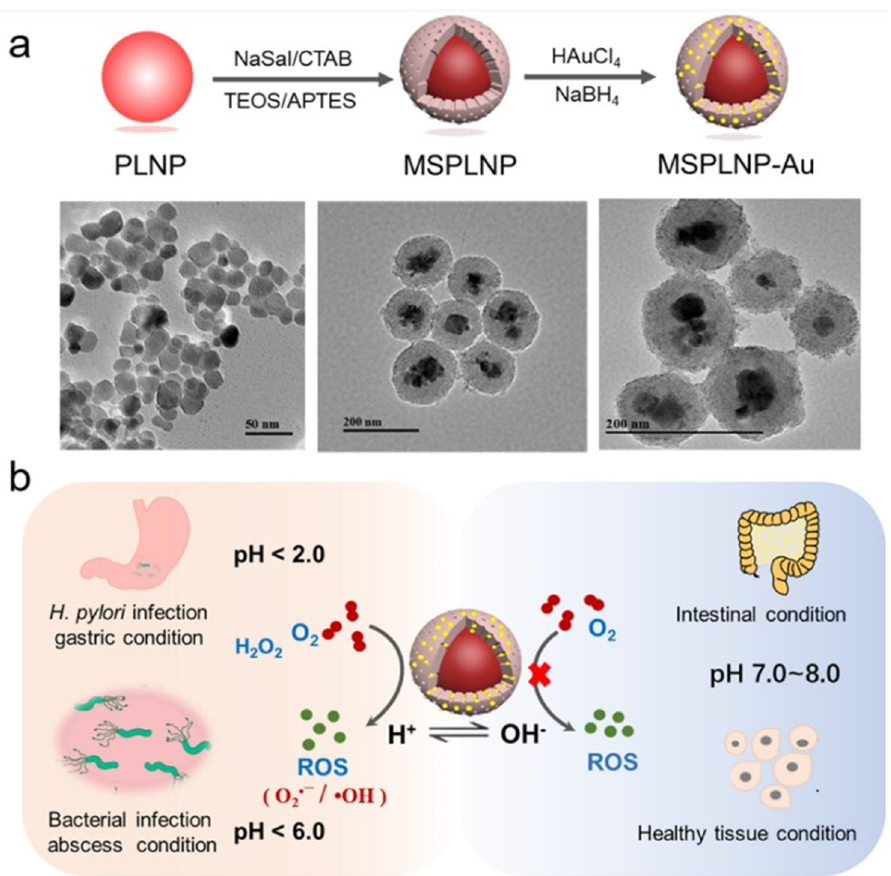
Figure 23. ( a ) Synthesis procedure for the obtention of mesoporous silica (MS) coated with persistent luminescence nanoparticles (MSPLNP) and with Au nanoparticles (AuNP); ( b ) pH responsiveness with OD and HRP-like activity in different biological environments. Reprinted with permission from [73]. Copyright © 2021 American Chemical Society.